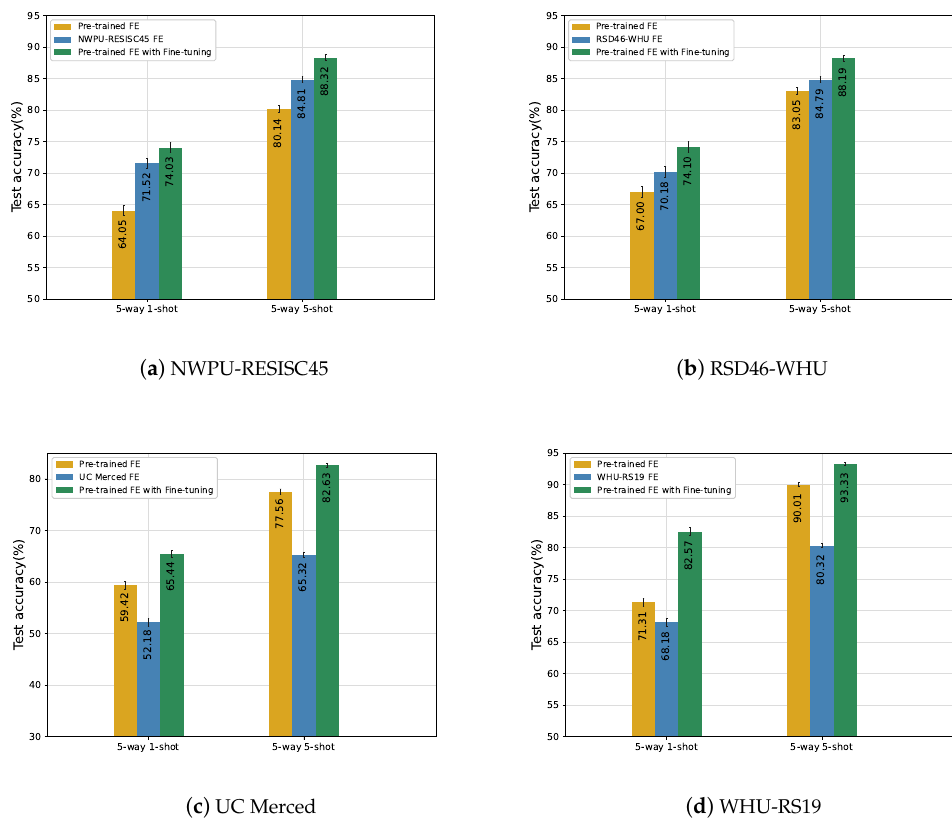
Figure 5. Influences of the pre-trained feature